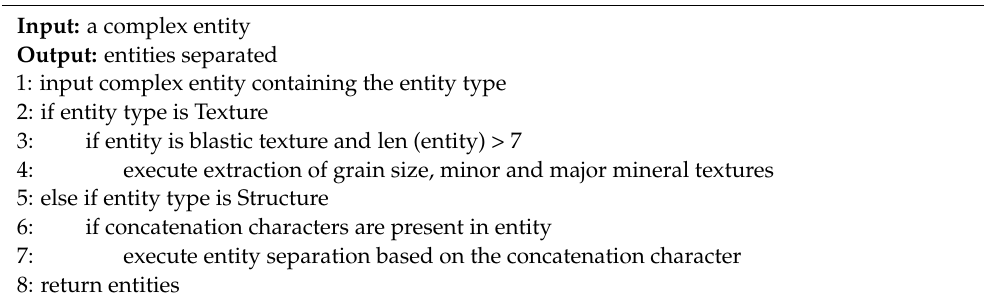
Algorithm 1. Complex entity separation